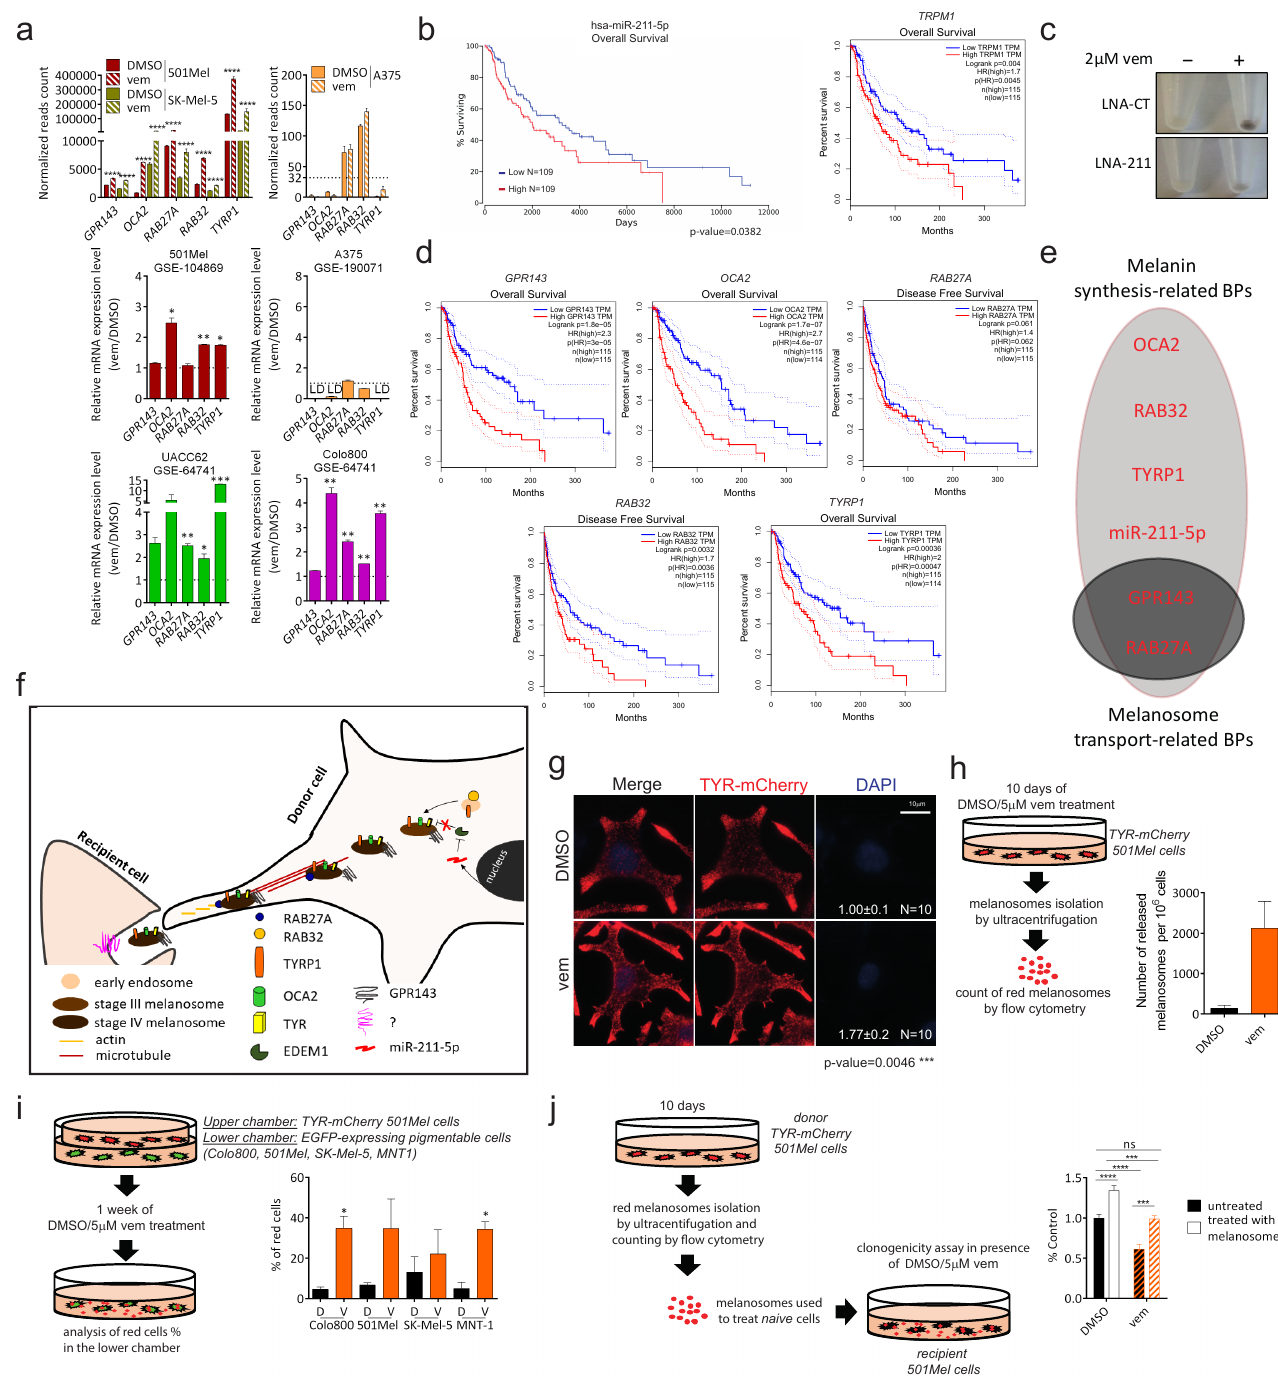
Figure 3. Involvement of DEmiRs and DEmRNAs in melanosome maturation and trafficking upon vem treatment. ( a ) Normalized reads count of GPR143 , OCA2 , RAB27A , RAB32 and TYRP1 DEmRNAs upon vem treatment. ( upper ) Our analysis: 501Mel cells (our RNA-seq, dark red), SK-Mel-5 cells (our RNA-seq, olive green), and A375 cells (GSE89129, orange). ( middle and lower ) Additional datasets: 501Mel cells (GSE104869), A375 cells (GSE190071), UACC62 cells (GSE64741), and Colo800 cells (GSE64741). LD: Low detection. ( b ) Kaplan–Meier curves for miR-211-5p (left ) and its host gene TRPM1 (right) , showing significantly worse overall survival for high miR-211-5p/ TRPM1 expressors (25% percentile, red) compared to low miR-211-5p/ TRPM1 expressors (25% percentile, blue). Kaplan– Meier curves were generated using the SKin Cutaneous Melanoma-SKCM dataset on http://www. oncolnc.org/ and http://gepia.cancer-pku.cn/ (accessed on 31 August 2022), respectively. ( c )